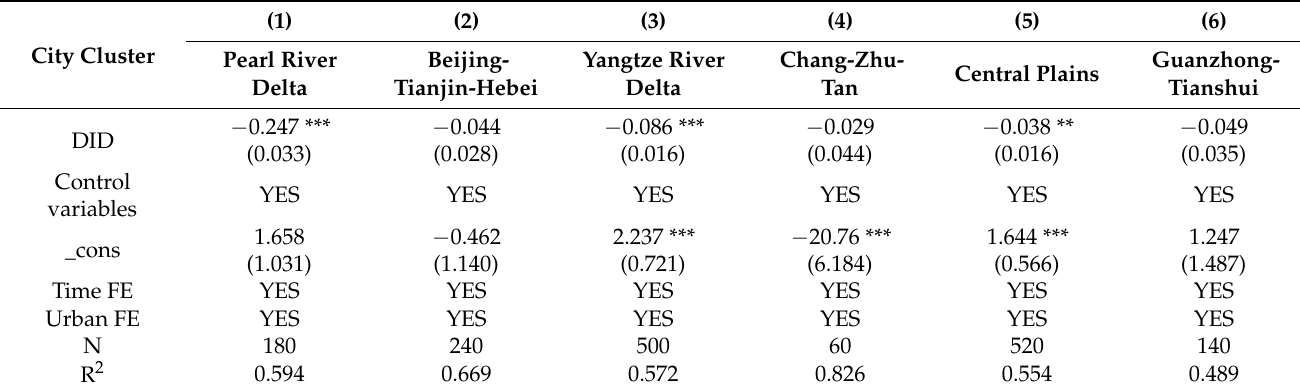
Table 6. Heterogeneity analysis of urban